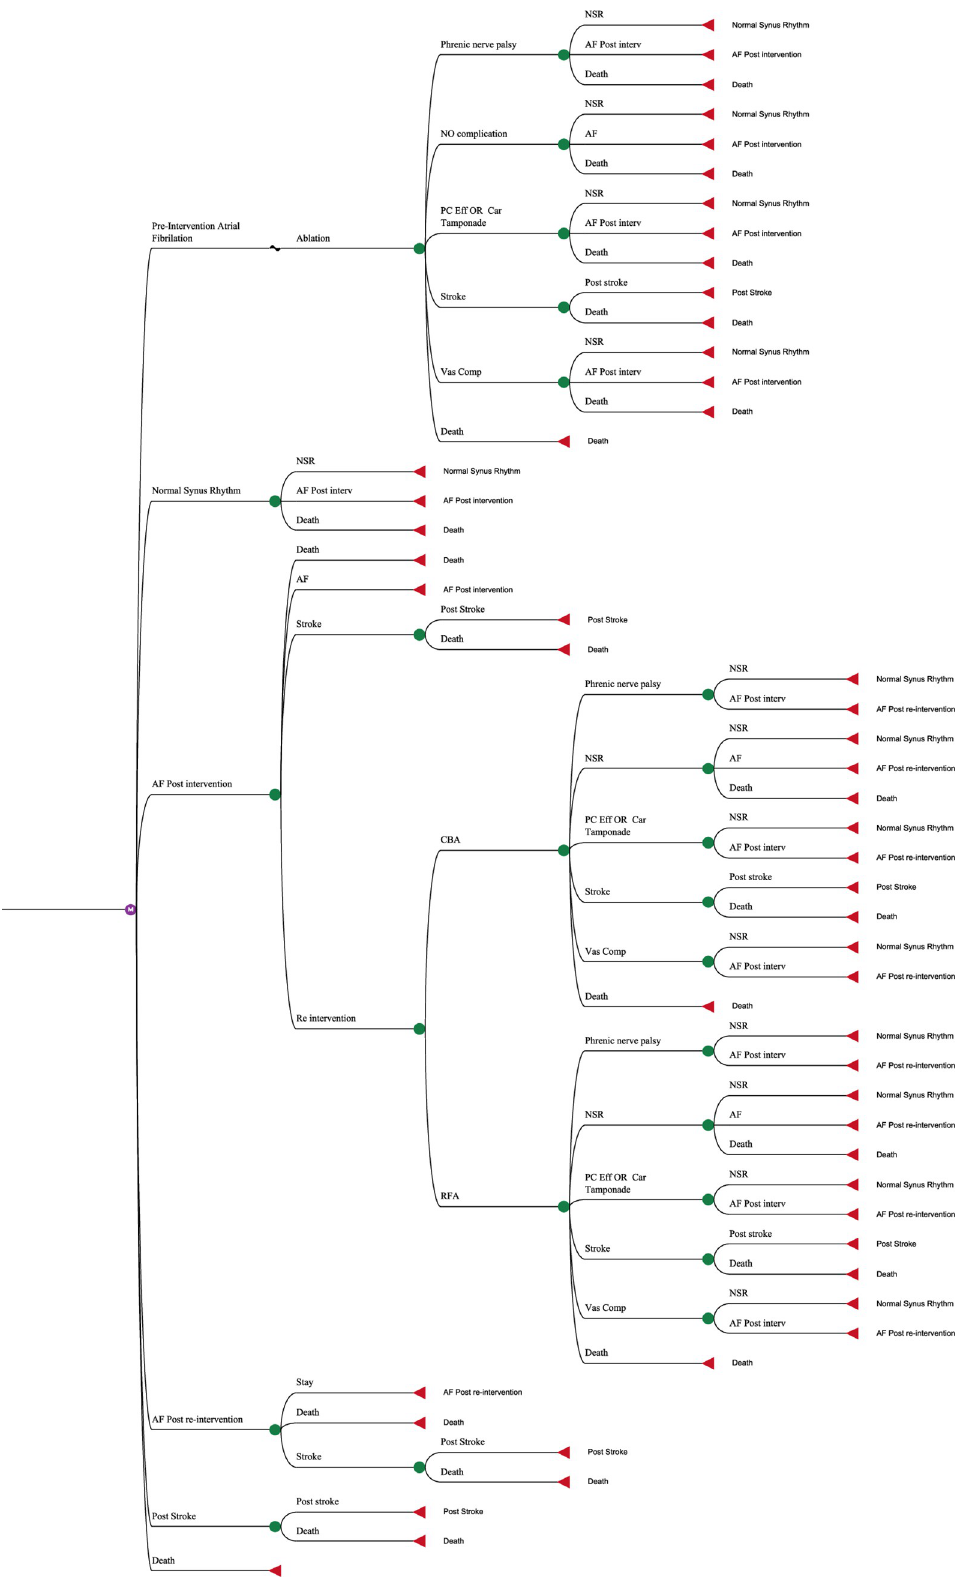
Fig 1. Markov model for CUA of CBA vs RFA. https://doi.org/10.1371/journal.pone.0270642.g001 PLOS ONE | https://doi.org/10.1371/journal.pone.0270642 July 6,